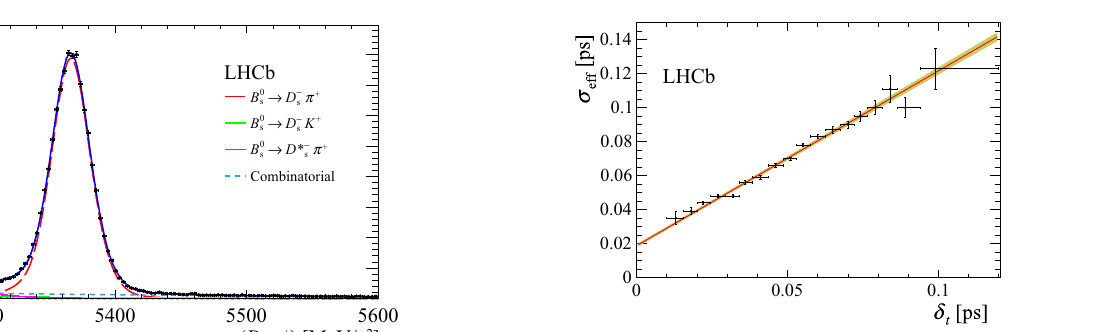
Fig. 8 Distribution of the invariant mass of selected B 0 s → D − s π + candidates (black points). The total fit function is shown as the solid blue line. The signal component is shown by the red long-dashed line, the combinatorial background by the light-blue short-dashed line and other small background components are also shown as specified in the legend. Only the dominant backgrounds are shown